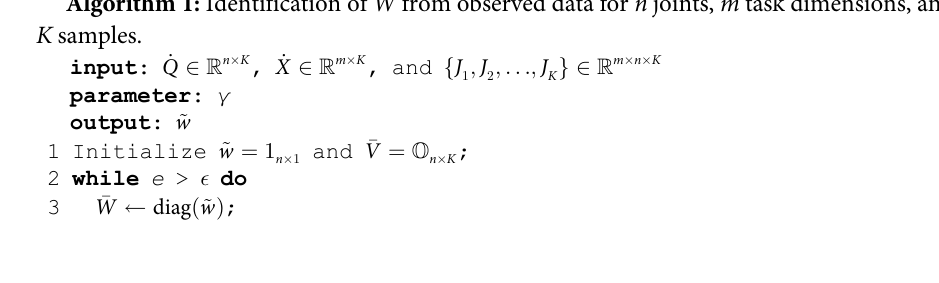
Algorithm 1: Identification of W from observed data for n joints, m task dimensions, and K